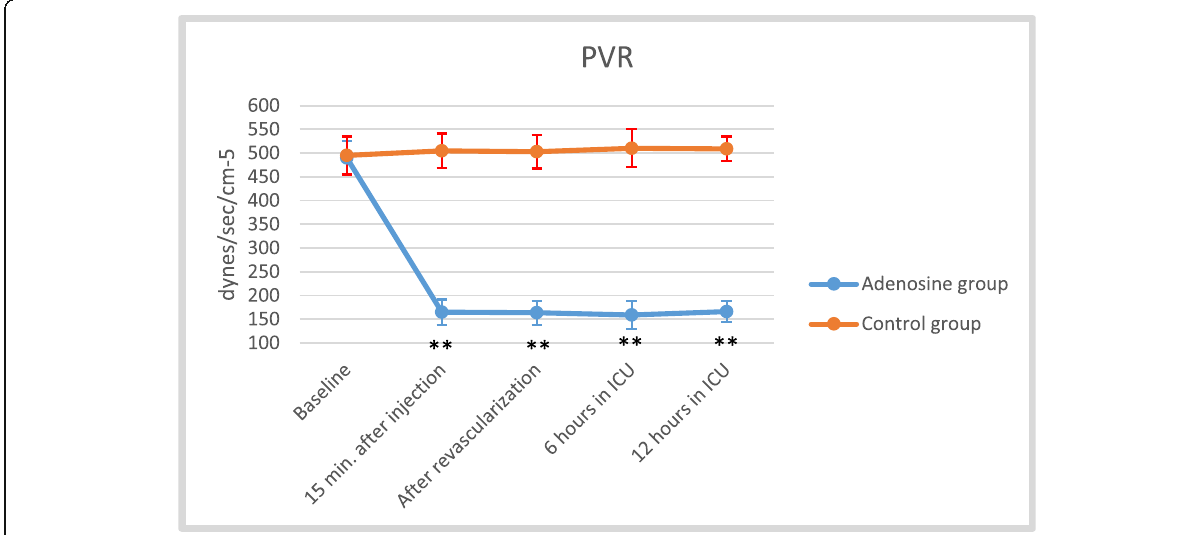
Fig. 8 Effect of adenosine on pulmonary vascular resistance (PVR). Data were presented as mean ± SD. ** p value is highly